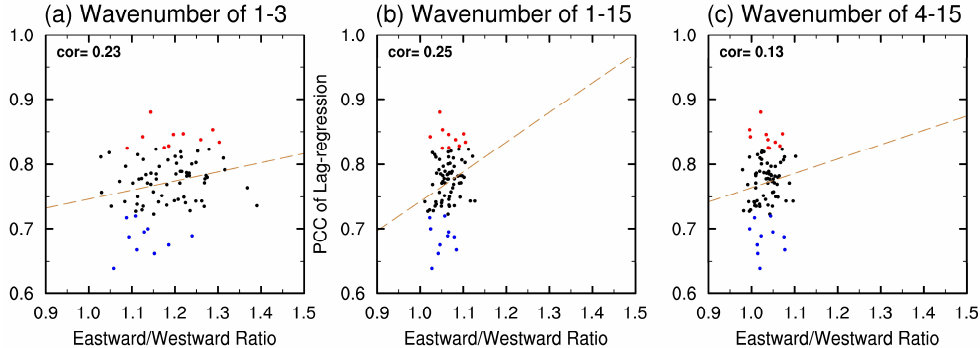
Figure 2. Scatter plot of scores by Lag-correlation (y axis) against scores by E/W ratio (x axis) of zonal wavenumber ( a ) 1–3, ( b ) 1–15, and ( c ) 4–15. The scores by Lag-correlation are the same as those in Figure 1. Scores by E/W ratio are defined as the values of dividing the spectra power in the eastward-propagating component by that in the westward-propagating component on MJO time and space scales (period of 30–90 days, zonal wavenumber of 1–3) in each run. The power spectral analysis is conducted with regional OLR (5° S–5° N; 60° E–180°) and then averaged meridionally. The 10 integrations identified by Lag-correlation as with stronger (weaker) MJO are scattered in red (blue) while the others in black. The dot line donates the linear fit by least squares means. The correlation coefficients are also displayed.